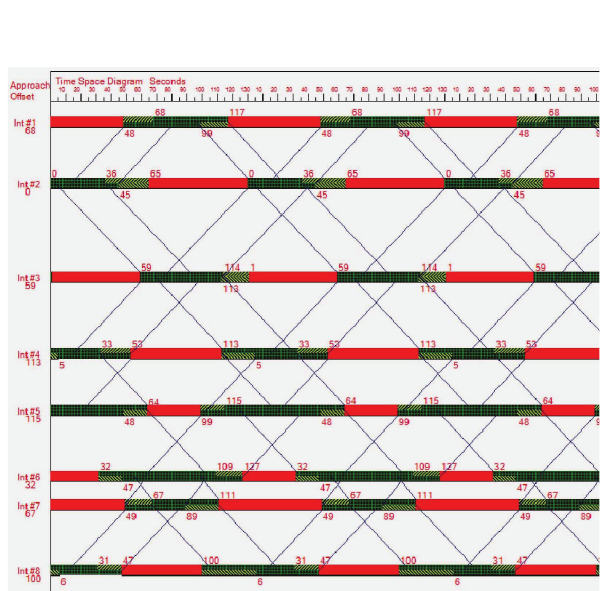
Figure 10: TSD of signal timing plan with practical travel